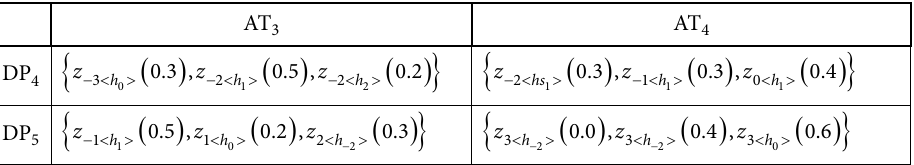
Table 2. The PDHLTSs evaluation of all alternatives is provided by e 2 AT 1 AT 2